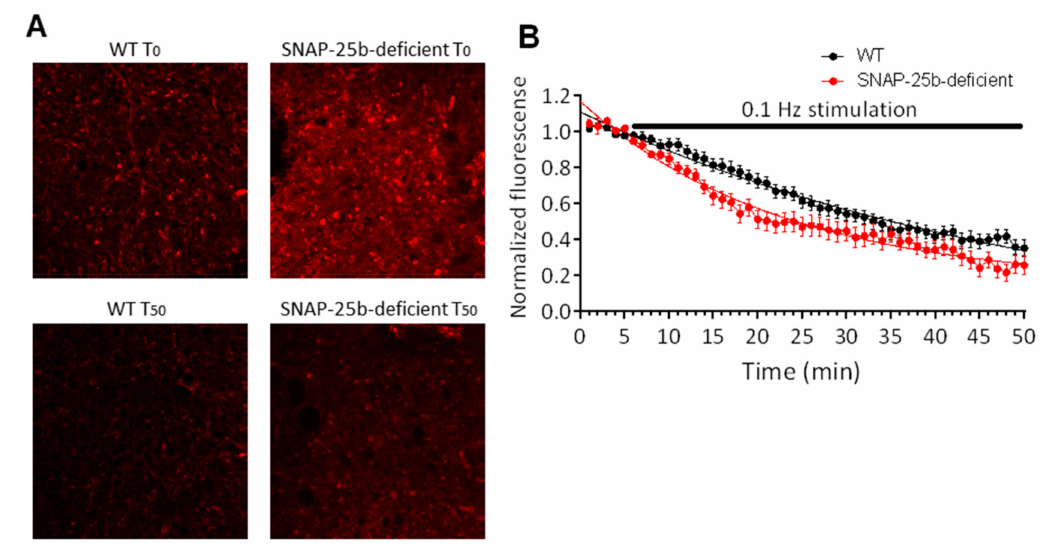
Figure 1. Presynaptic vesicular release from Scha ff er collateral terminals in one month old SNAP-25b-deficient mice. ( A ) Representative fluorescent images of hippocampal field CA1 stratum radiatum in slices from WT and SNAP-25b-deficient mice prior to synaptic stimulation (T 0 ) and after 50 min of 2Hz stimulation (T 50 ). Bright puncta are presynaptic Scha ff er collateral terminals. ( B ) Fluorescence decay of vesicular dye FM1-43 from Scha ff er collateral-CA1 presynaptic boutons elicited by 0.1 Hz stimulation (black bar). SNAP-25b-deficient mice (filled circles, n = 20 puncta from 4 slices) showed a significantly faster rate of FM1-43 decay compared to wild type mice (open circles, n = 18 puncta from 6 slices). Each point is mean ± SEM of ‘n’